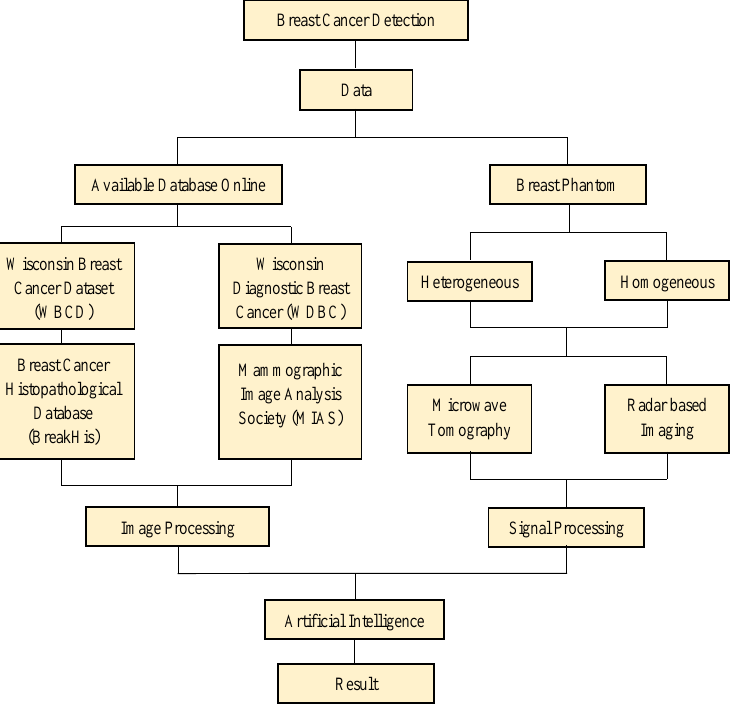
Figure 11. Research area in breast cancer detection using image processing and signal